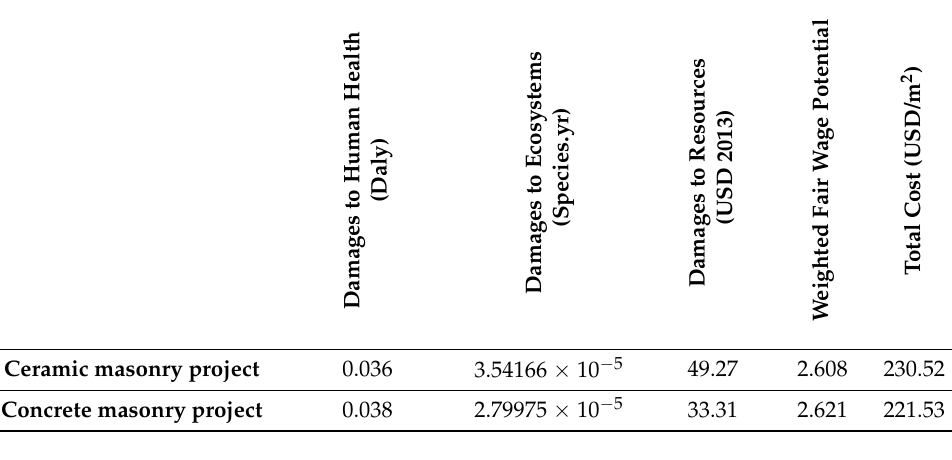
Table 12. Egalitarian perspective: